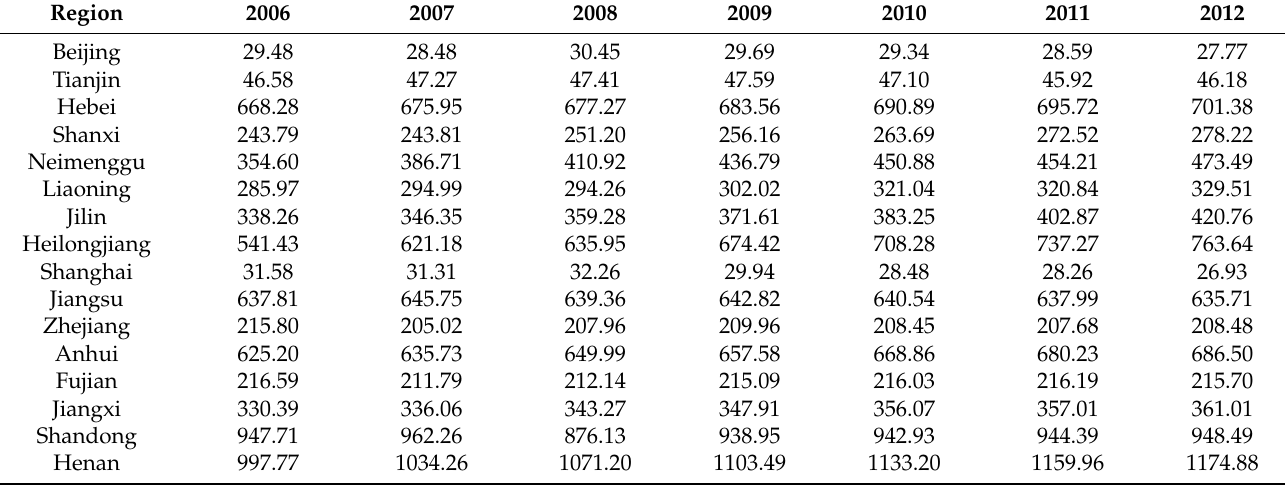
Table A2. Carbon emissions (10 4 t) from the planting industry in rural China from 1998–2019 (continued Table A1).